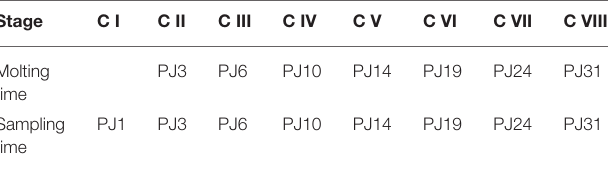
TABLE 1 | The molting and sampling time at the different stages of the Scylla paramamosain